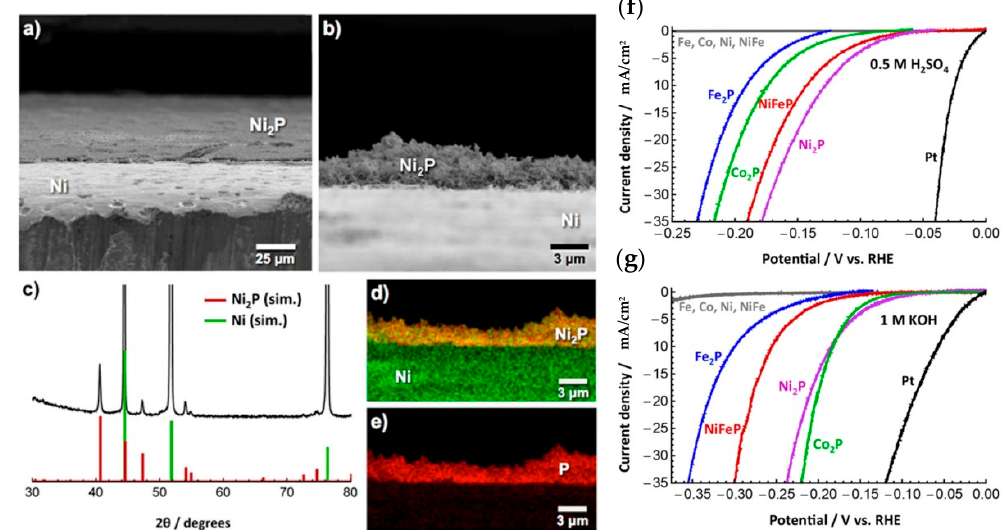
Figure 5. ( a , b ) SEM images of a representative Ni 2 P film on Ni; ( c ) Experimental powder XRD pattern of a Ni2P sample (black), with the simulated (sim.) patterns of Ni (green) and Ni 2 P (red) shown for comparison. The y ‐ axis was truncated to highlight the Ni 2 P as the Ni signal would otherwise dominate; ( d , e ) EDS elemental maps of a cross ‐ section of the sample showing the presence of both Ni (green) and P (red) in a 2:1 ratio; ( f ) Polarization data for the HER in 0.5 M H 2 SO 4 and ( g ) 1 M KOH for a series of metal phosphide films, along with a Pt mesh electrode for comparison. Reprinted with permission from [113]. Copyright 2017 The Royal Society of Chemistry.